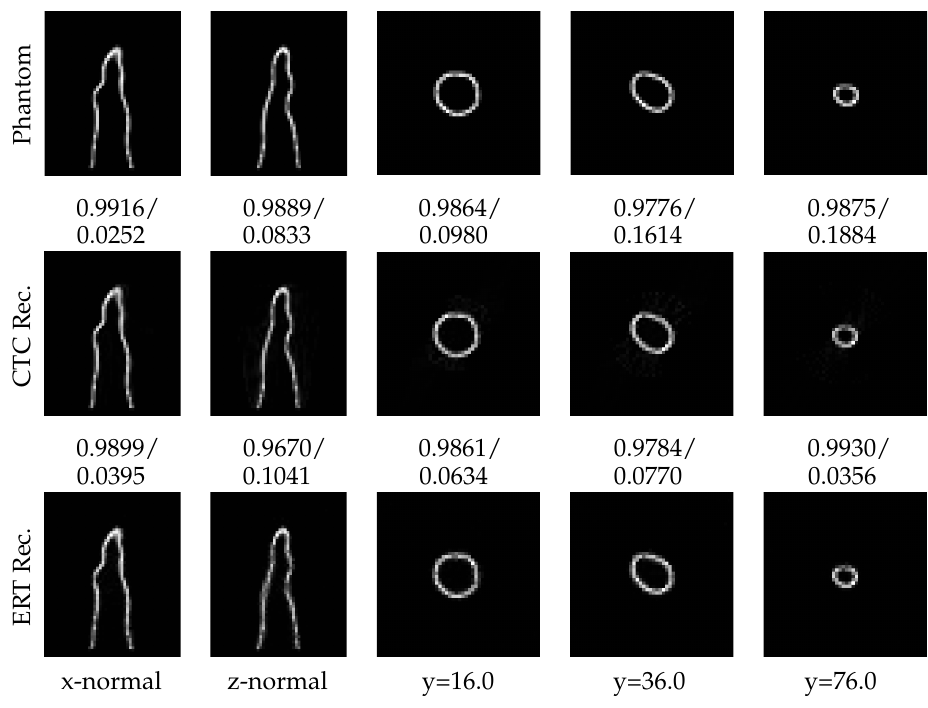
Figure 8. Slices normal to each spatial axis and height above burner exit (in mm), the correlation/normalized Manhattan distance to the phantom of each pair of slices is displayed between the